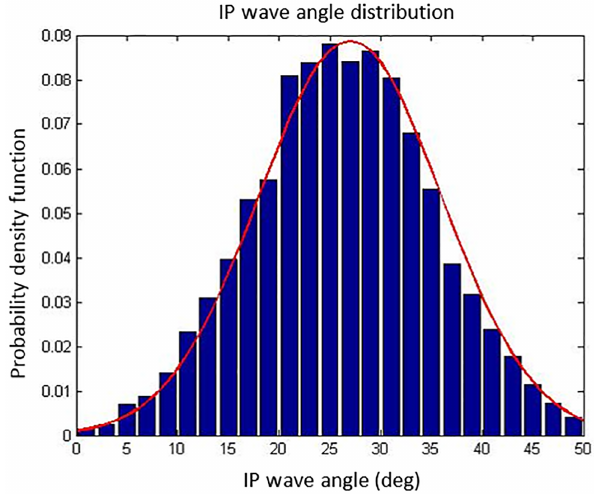
Figure 12. Distribution of sampled magnitudes of IP fiber misalign- ment angles used in Case 1.